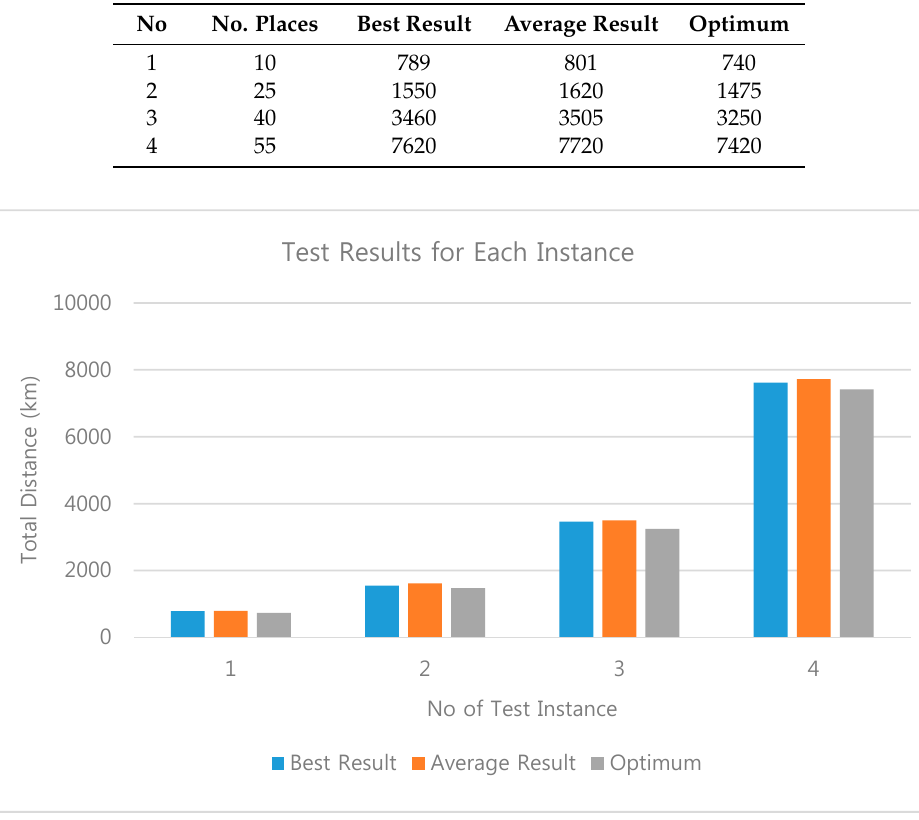
Figure 12. Performance analysis graph of different test instances.